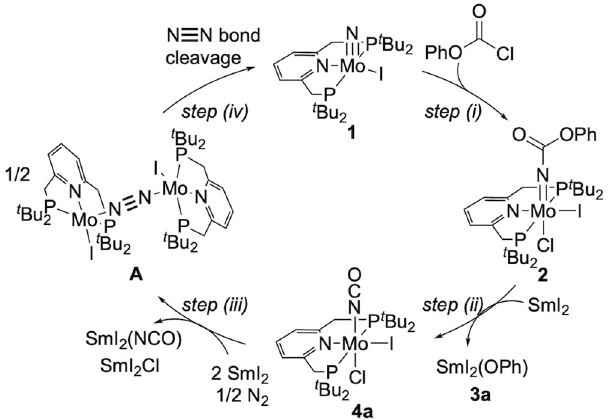
Fig.4|Aproposedreactionpathwayforproducingisocyanatederivativesfrom dinitrogen. (i) The carbamylation of nitride complex 1 with phenyl chloroformate affords carbamate complex 2 . (ii) Reductive carbon − oxygen bond cleavage in the carbamate ligand of 2 produces isocyanate complex 4a . (iii) After one-electron reduction, the dissociation of the chloride ligand of 4a affords a fi ve-coordinate isocyanate complex. A pair of the isocyanate complex sandwiches a dinitrogen molecule to form a dinitrogen-bridged dimolybdenum complex with a Mo – N ≡ N – Mo core, whichisa precursor of[{MoI(PNP)} 2 ( μ -N 2 )] A . (iv) The bridging N 2 ligand of A undergoes a direct N ≡ N bond cleavage to regenerate 1